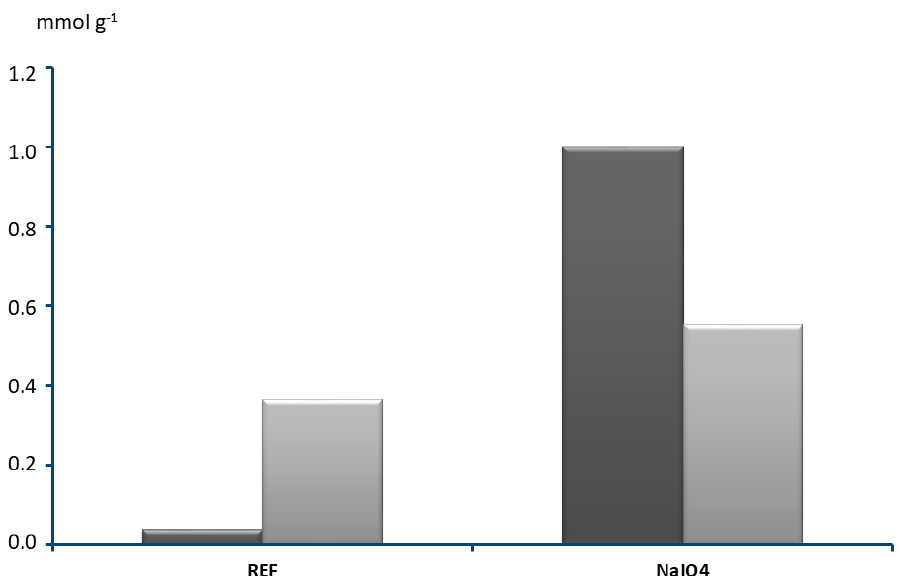
Figure 5. Comparison of the content (mmol · g − 1 ) of carbonyl (light gray) and carboxylic groups (black) in samples of milled RH before and after different oxidative treatment.